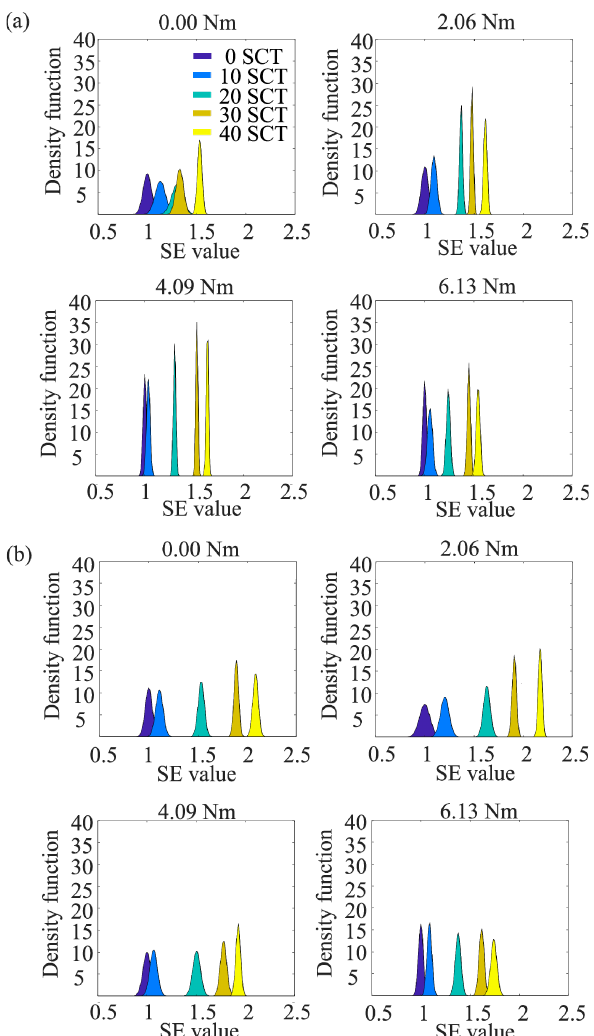
Figure 8. Gaussian distribution functions for ( a ) SE L and ( b ) SE R at both different loads and different fault severities.